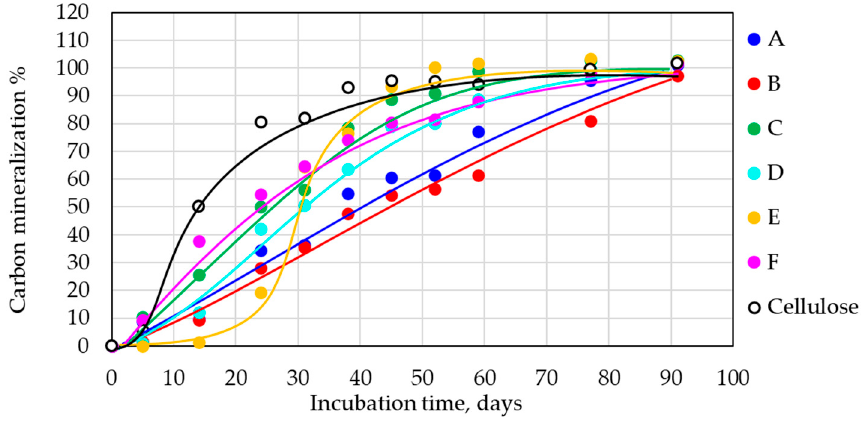
Figure 2. Mineralization of samples under industrial composting conditions, 58 °C.